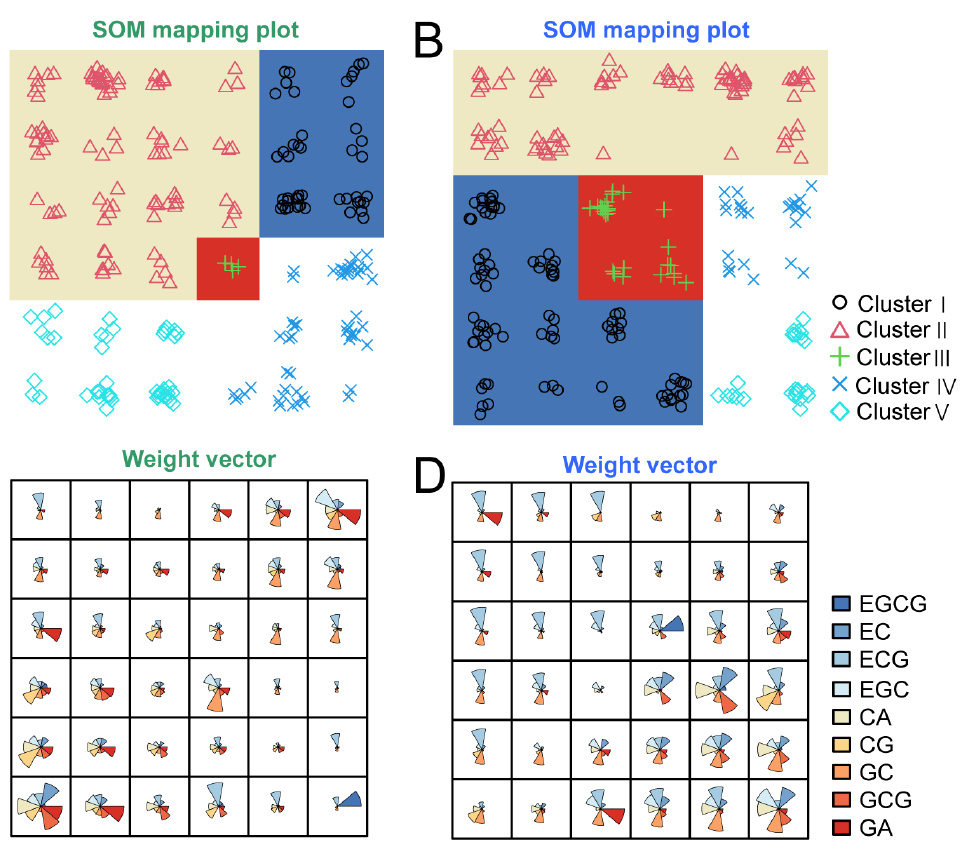
Figure 5. SOM cluster results of 249 persimmon germplasms according to content of 9 catechins. The 6 × 6 grid containing 36 neurons and 5 clusters represents the SOM cluster results of 249 persimmon young leaves ( A ) and adult leaves ( B ). Different background color and symbols represents different clusters. Catechin distribution patterns of 249 persimmon young leaves ( C ) and adult leaves ( D ) in 36